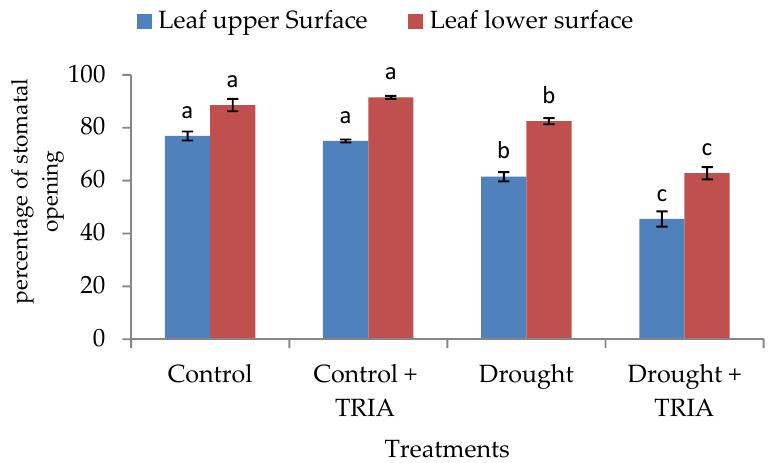
Figure 2. Effect of TRIA (35 ppm) treatment on percentage of stomatal openings on both the upper and lower surface of leaves of drought-stressed rice. Each value is the mean of three replicates ± SE. Columns with different letters are significantly different at p ≤ 0.05.